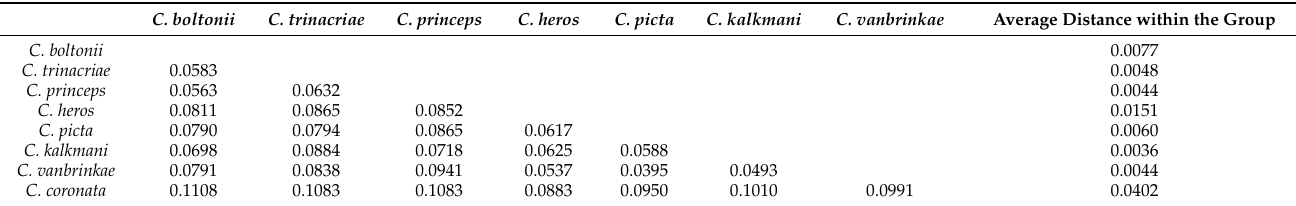
Table 3. Genetic distance, estimated by the Kimura 2-parameter method, between the different species in the Codulegaster boltonii- group and C. coronata